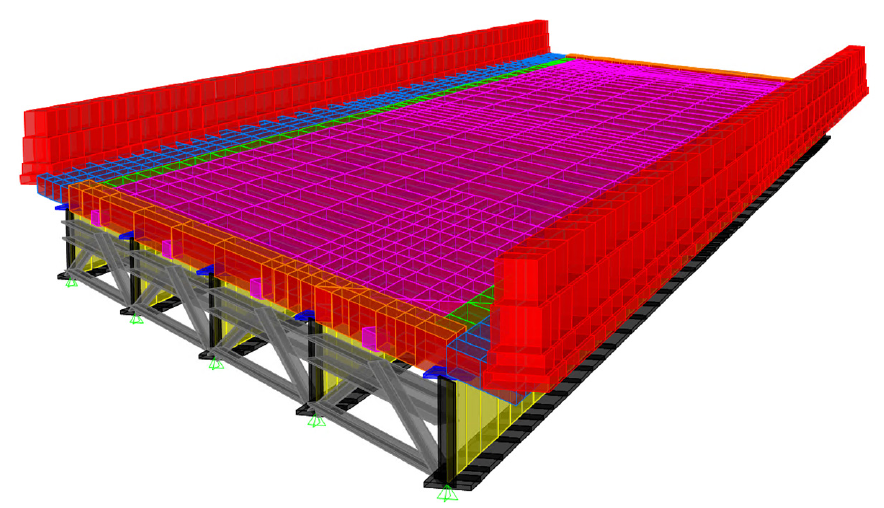
Figure 9. Comprehensive view of 3D model of prototype bridges from CSiBridge. For shell sections within the acute corner, the angle of the shell layers corresponding to transverse reinforcement were changed to match the skew alignment. However, each shell element has three orthogonal local axes which define the direction of the output forces and stresses and set the orientation of the shell layers. Although the local axes can be rotated, they are always normal to each other. Therefore, to observe the stress in the skew reinforcement, a subset of models was created for each skew angle in which the shell local axes in the acute corner were rotated accordingly. It should be noted that the reinforcement in the subset models are identical to the main prototype models.